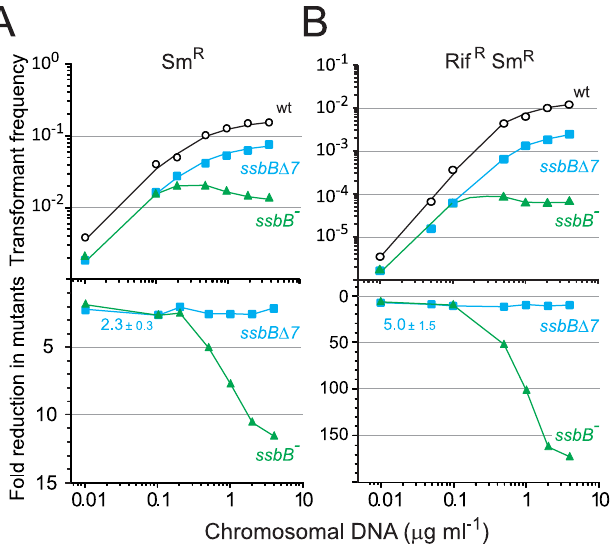
Figure 6. Single and double transformation frequency in wildtype, ssbB 2 , and ssbB D 7 cells. (A) Competent cells ( , 3.0 10 8 cfu ml 2 1 ) of strain R1818 ( ssbB + ), R2647 ( ssbB D 7 ) and R2646 ( ssbB 2 ) were exposed to various concentrations of R304 chromosomal DNA and Sm R transformants were scored. Data represent the compilation of six independent experiments shown in Figure S3 (left panel). Bottom panel: ratio between the number of Sm R transformants in ssbB mutant and wildtype cells calculated from data in top panel. (B) Same conditions as in panel A but scoring for Rif R Sm R double transformants. Data represent the compilation of four independent experiments shown in Figure S3 (rigth panel). Bottom panel: ratio between the number of Rif R Sm R transformants in ssbB mutant and wildtype cells calculated from data in top panel.